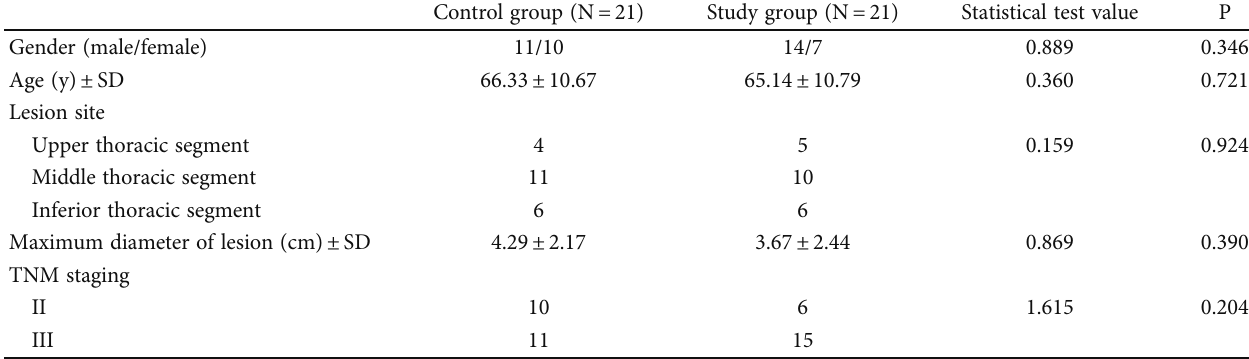
Table 1: Comparison of clinical data between high dose group and low dose group after propensity score matching.